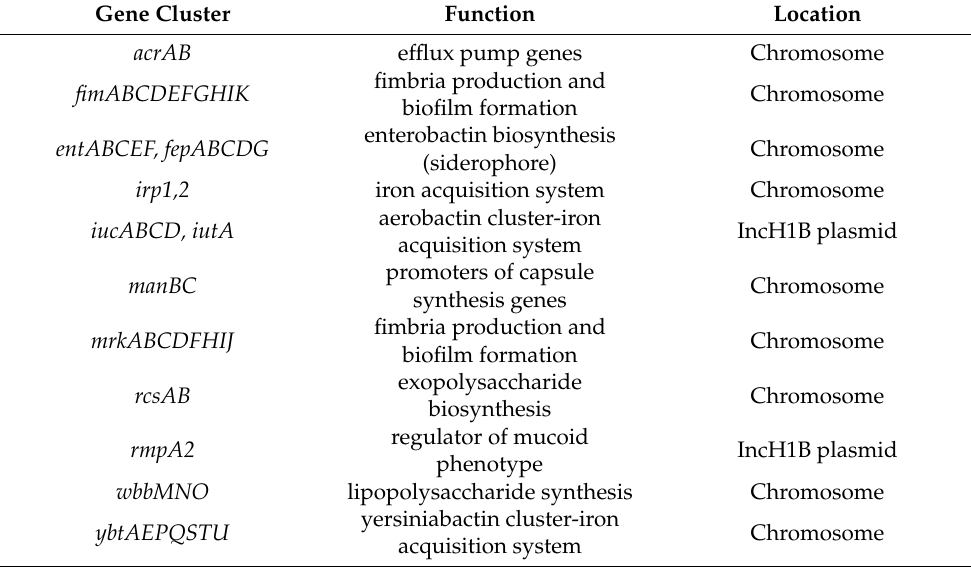
Table 2. Description of important virulence gene clusters in clinical K. pneumoniae isolates studied.